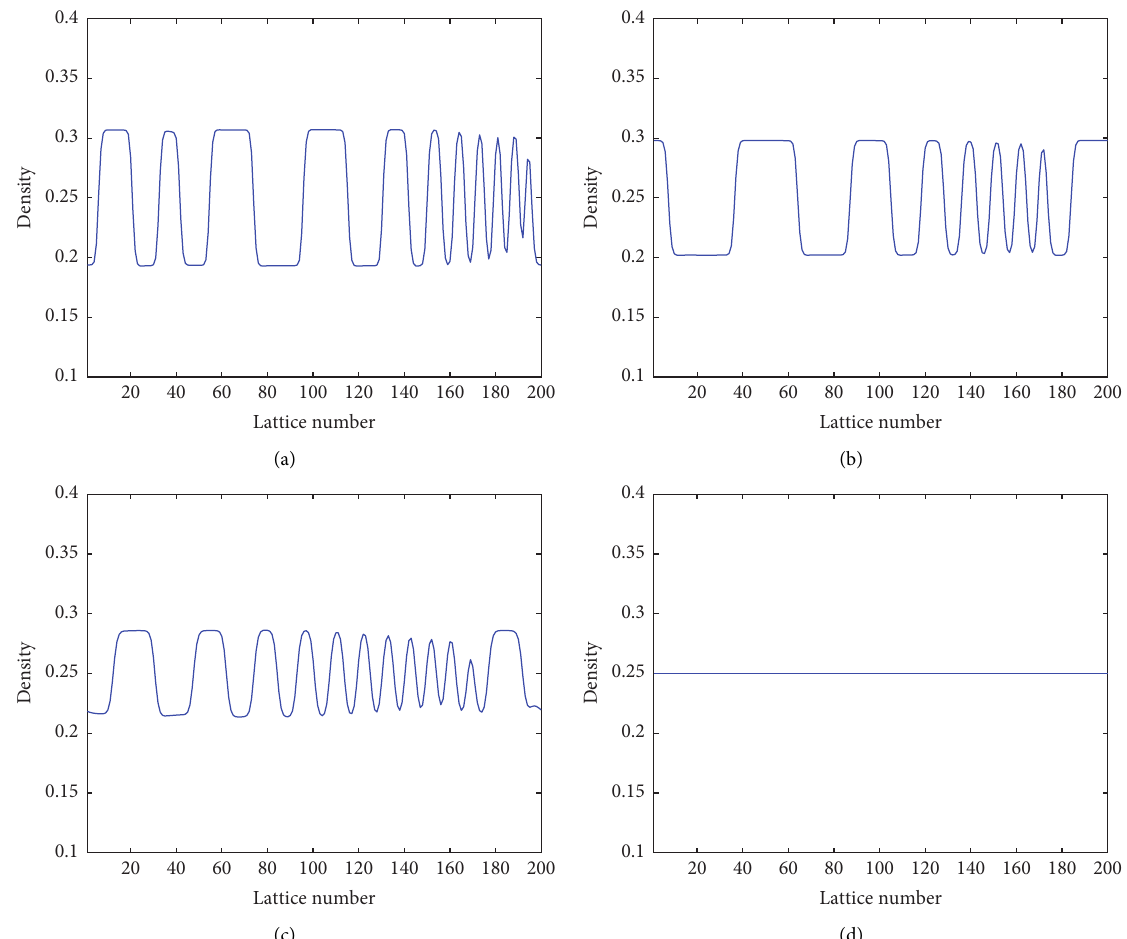
Figure 5: The density profile at t � 10200 with different values of τ : (a) τ � 1 . 0; (b) τ � 1 . 5; (c) τ � 2 . 0; (d) τ � 2 .